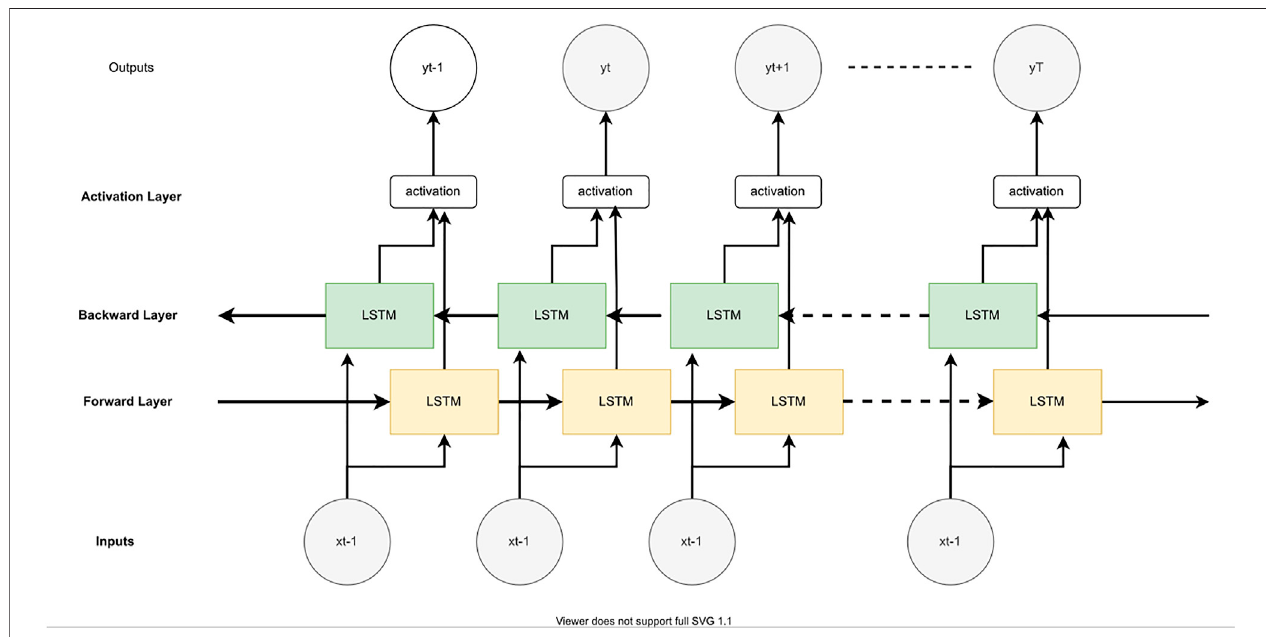
FIGURE 5 | The architecture of Bidirectional-LSTM.